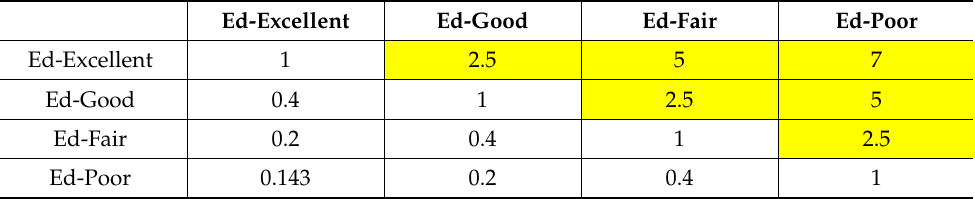
Table 12. Pairwise Comparisons for the Education Criterion.